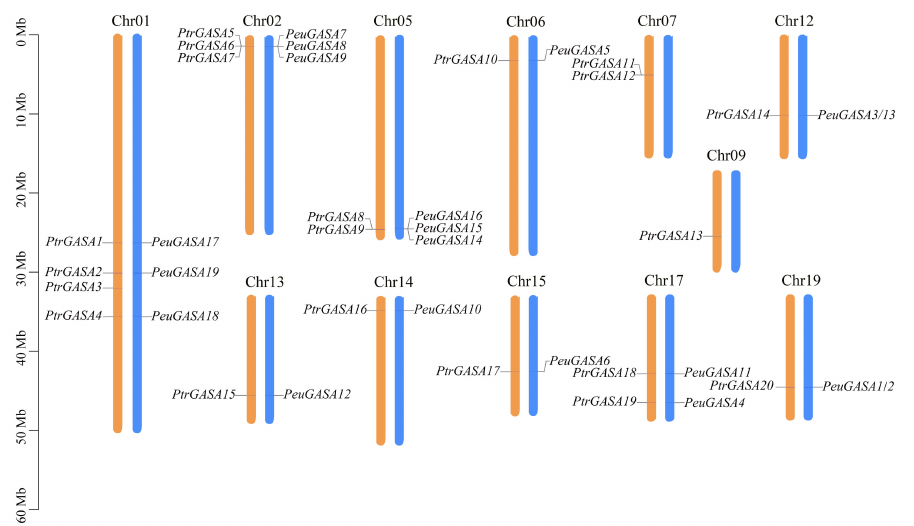
Figure 1. Positions of PtrGASA and PeuGASA genes on P. trichocarpa chromosomes. The P. trichocarpa chromosomes where the PtrGASA genes are located are shown in orange. The reference P. trichocarpa chromosomes where the PeuGASA genes are located are shown in blue. The positions of genes and the size of chromosomes can be estimated using the scale on the left of the